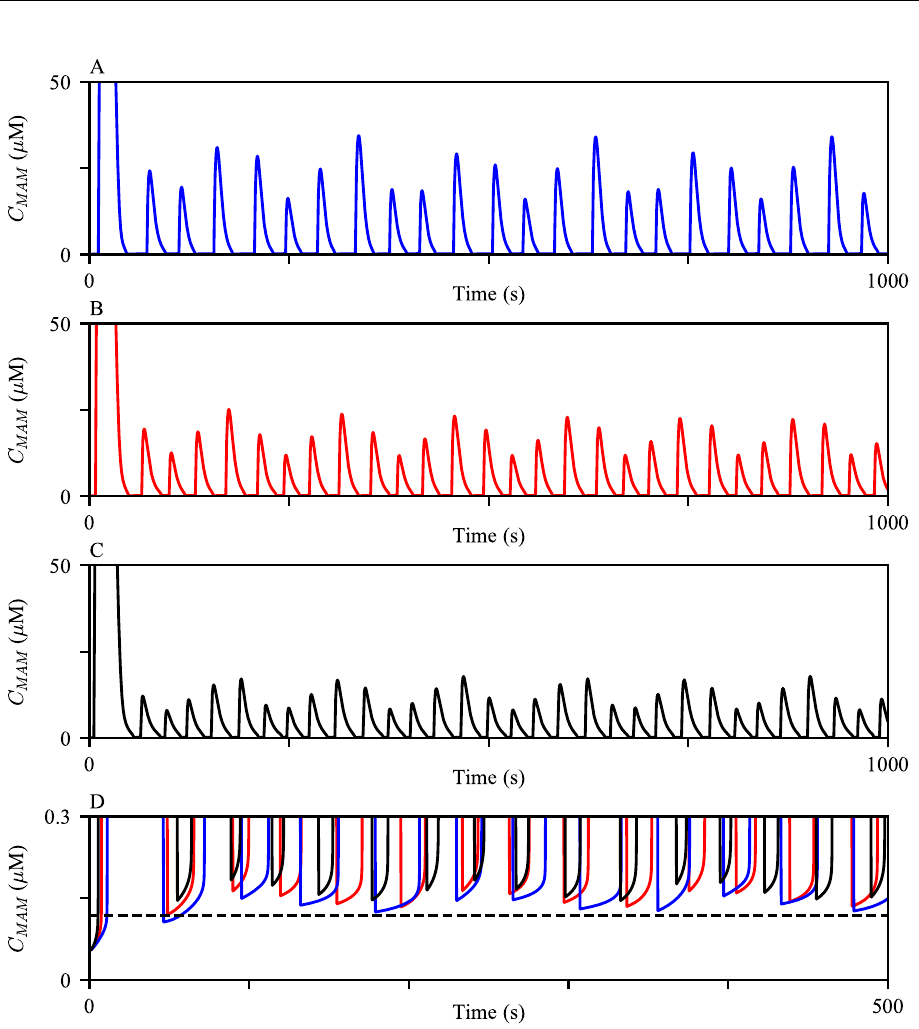
Fig 5. MAM Ca 2+ oscillations generated with varying V nSERCA . The oscillations were generated with (A) V nSERCA = 12 μ M s − 1 , (B) V nSERCA = 10 μ M s − 1 , and (C) V nSERCA = 8 μ M s − 1 . (D) Zoomed in at the basal level of MAM Ca 2+ concentration after a spike, with different values of V nSERCA . The black dashed line indicates the cytosolic Ca 2+ concentration right after a spike. For all three simulations, the model was given continuous stimulation of IP 3 with P 0.3 μ